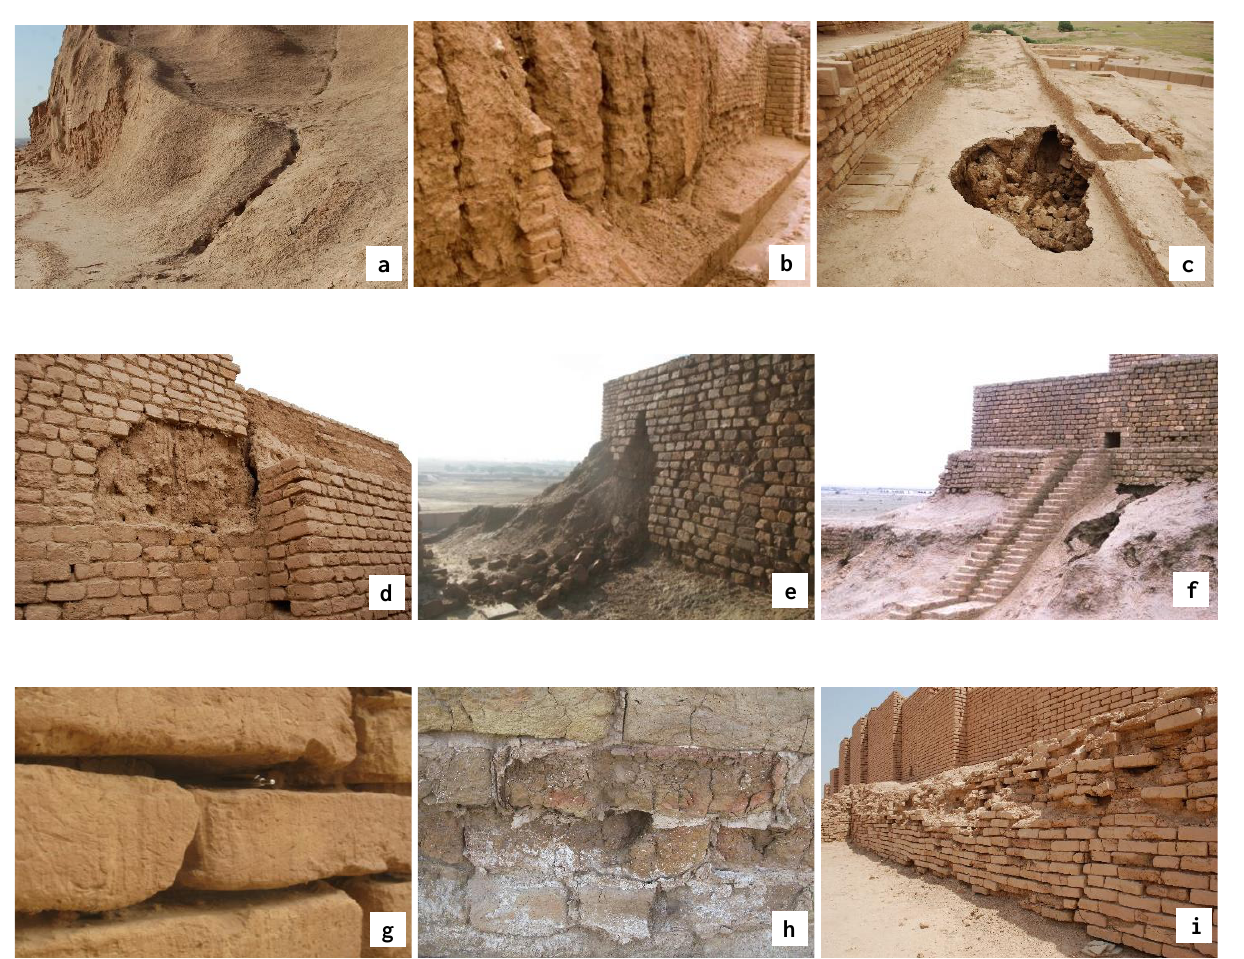
Figure 3. Architectural structure of historical drains in the ziggurat and walls (Archive of Tchogha Zanbil center).